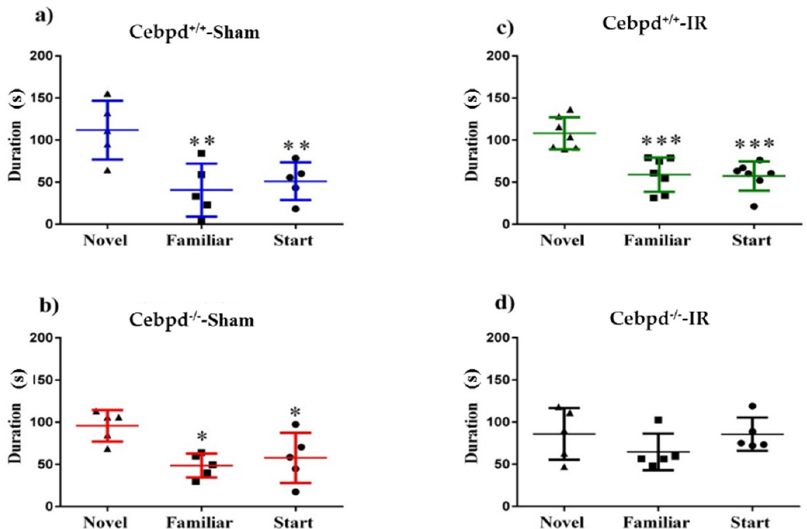
Figure 1. Short-term memory analyzed by Y-maze test in sham and irradiated aged Cebpd +/+ and Cebpd − / − mice. ( A – C ) Cebpd +/+ -sham, Cebpd +/+ -IR, and Cebpd − / − -sham mice were able to successfully distinguish